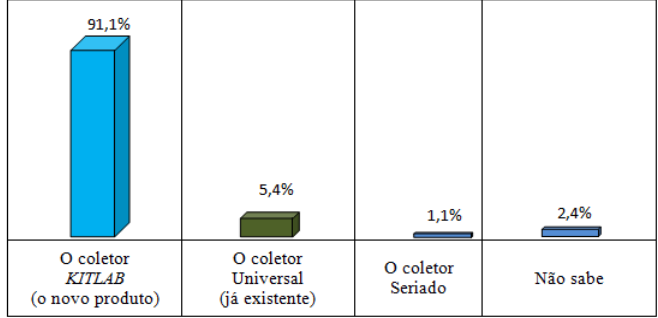
Figura 11. Percentual em relação ao produto mais prático. A figura 12 mostra o percentual de entrevistados quanto à avaliação do produto com nota de 1 a 10.